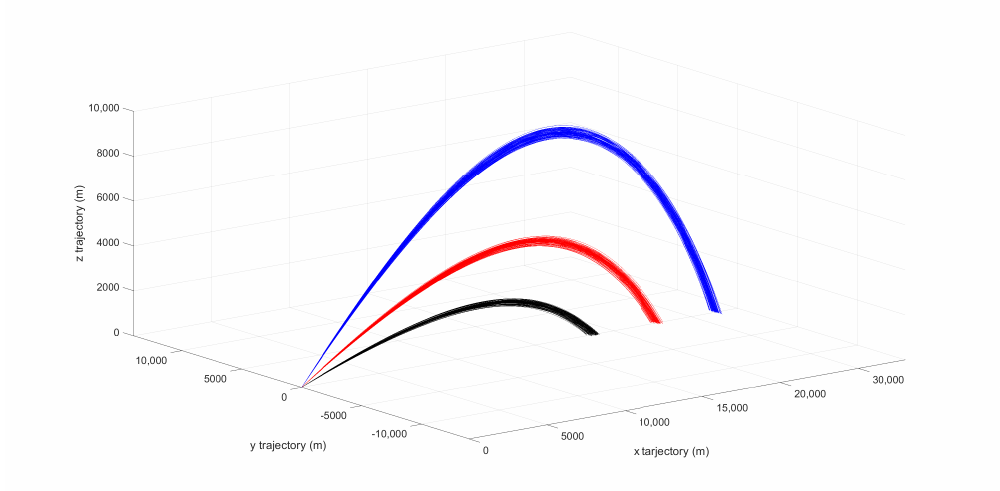
Figure 3. Noncontrolled flights for 20 ◦ (black), 30 ◦ (red) and 45 ◦ (blue) initial pitch